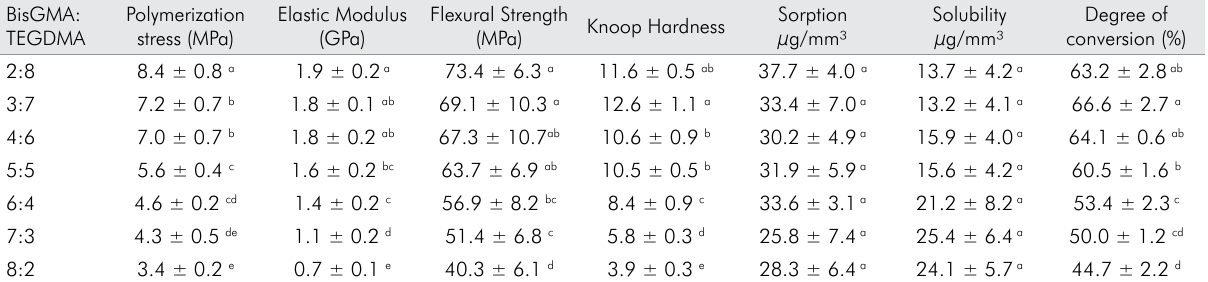
Table 1. Means ± standard deviation of polymerization stress (MPa), elastic modulus (GPa), flexural strength (MPa), Knoop hardness, sorption (μg/mm³), solubility (μg/mm³) and degree of conversion (%) of experimental composites containing BisGMA and TEGDMA at different ratios and 40wt% of colloidal silica.